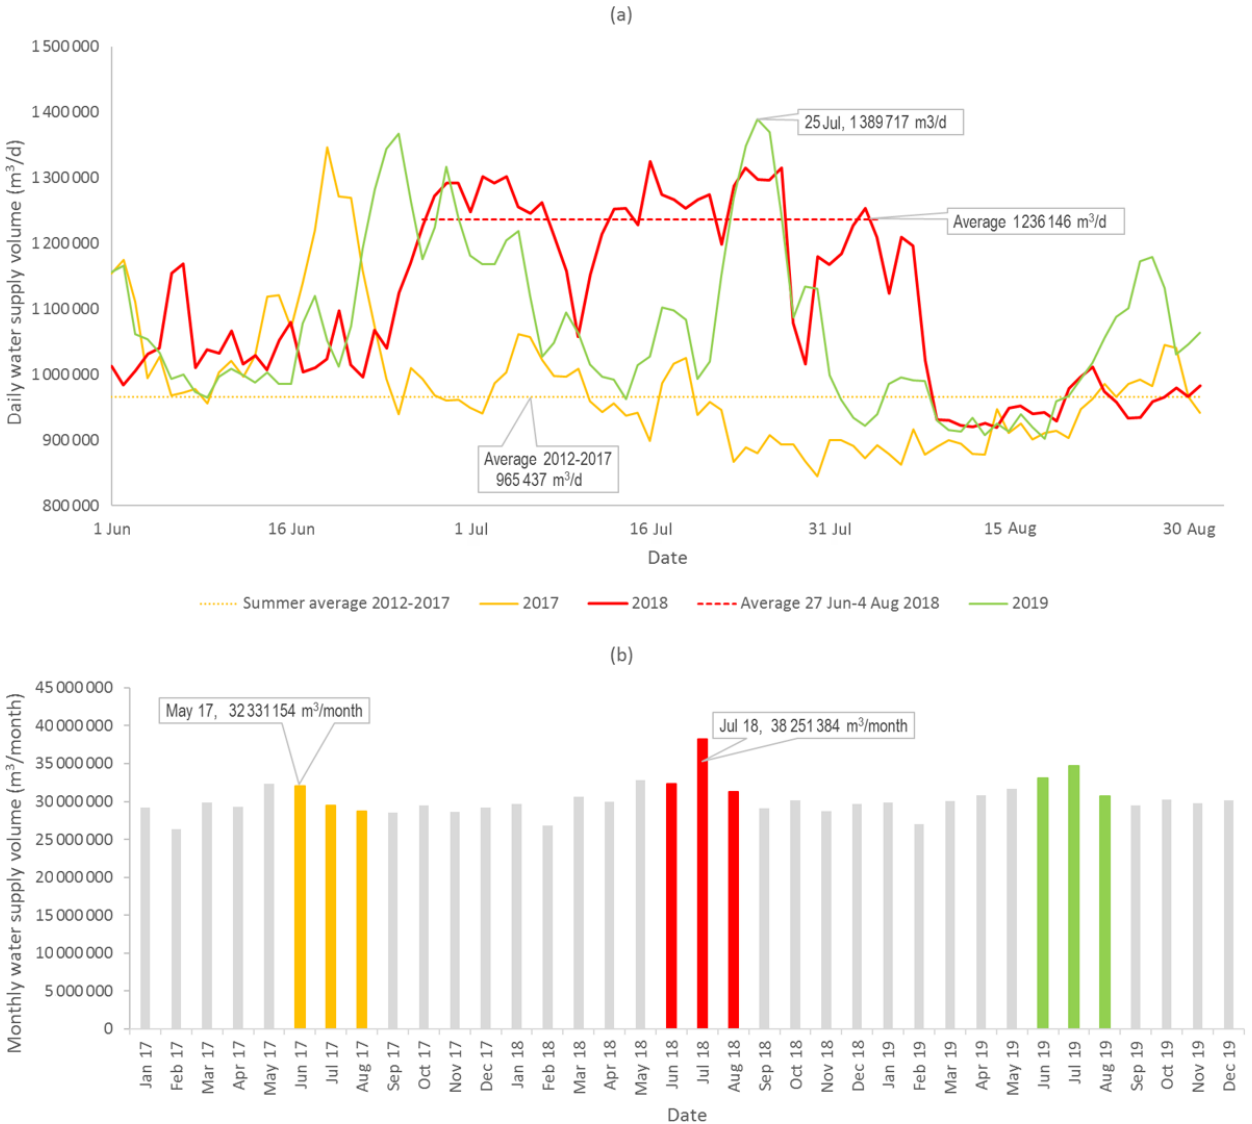
Figure 1. Daily (a) and monthly (b) drinking water supply volume by Dutch drinking water supplier Vitens during summer 2017 (average), 2018 (extreme), and 2019 (high) (Van Engelenburg et al., unpublished,